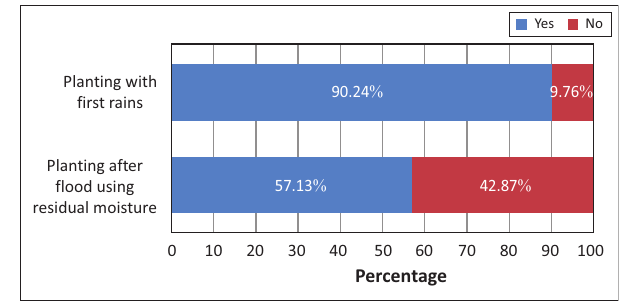
FIGURE 6: Planting earlier or later than the traditional planting period.